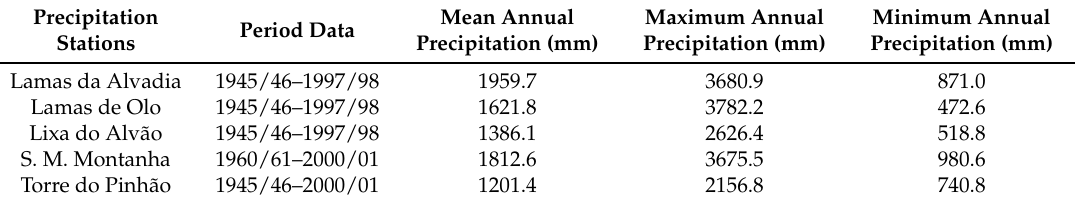
Table 1. Mean, maximum, and minimum annual values of precipitation